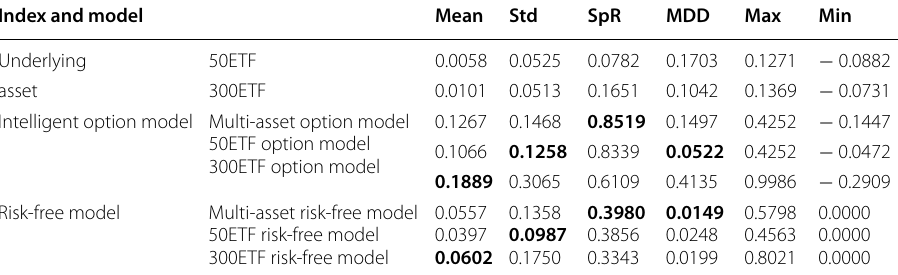
Table 8 Performance of 50ETF, intelligent option model, and risk-free model under multi-asset